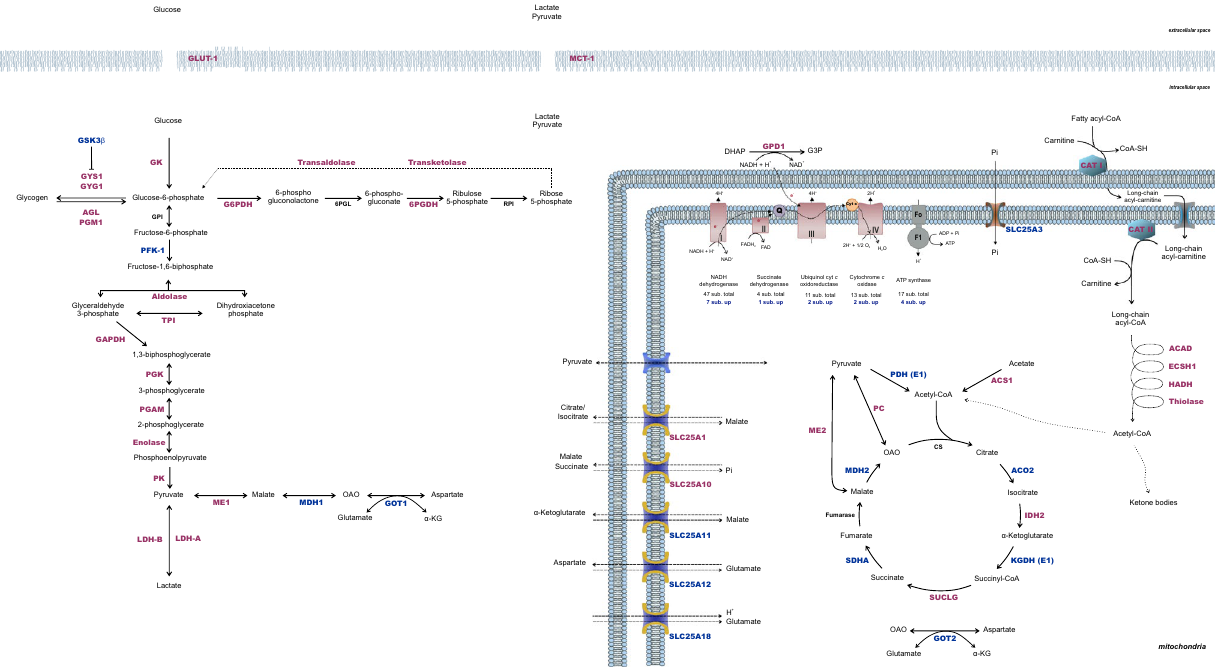
Figure 1. Differentially expressed proteins associated with energy metabolism pathways in rat hippocampus. Proteins in pink represent increased abundance in female hippocampus and proteins in blue represent increased abundance in male hippocampus (n = 5 biological replicates, each containing 3 slices). To simplify understanding, the number of upregulated subunits of mitochondrial respiratory chain complexes was indicated below the number of total subunits of each complex. For more details, see Supplementary Dataset 1. Statistical analyses were performed using Student’s t test followed by multiple testing corrections using the Benjamini– Hochberg procedure for false discovery